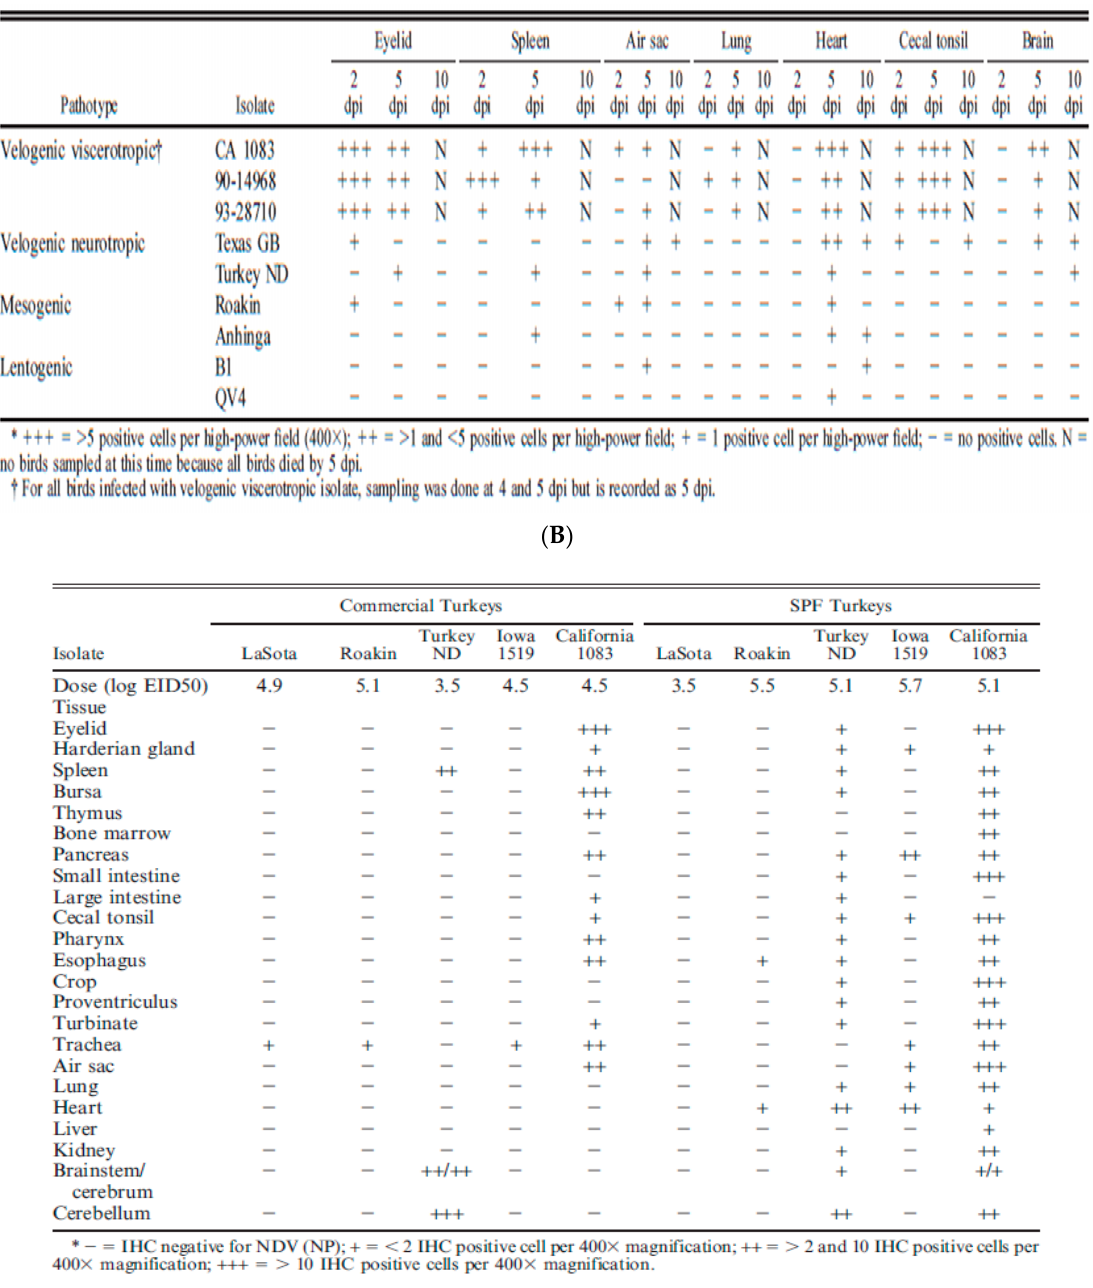
Figure 5. Pathogenesis comparison between vvNDV and vnNDV. ( A ) Excerpts from Brown, C.; King, D.J.; Seal, B.S. Pathogenesis of Newcastle Disease in Chickens Experimentally Infected with Viruses of Different Virulence. [16]. ( B ) Excerpts from Piacenti, A.M.; King, D.J.; Seal, B.S.; Zhang, J.; Brown, C.C. Pathogenesis of Newcastle disease in commercial and specific pathogen-free turkeys experimentally infected with isolates of different virulence. [73]